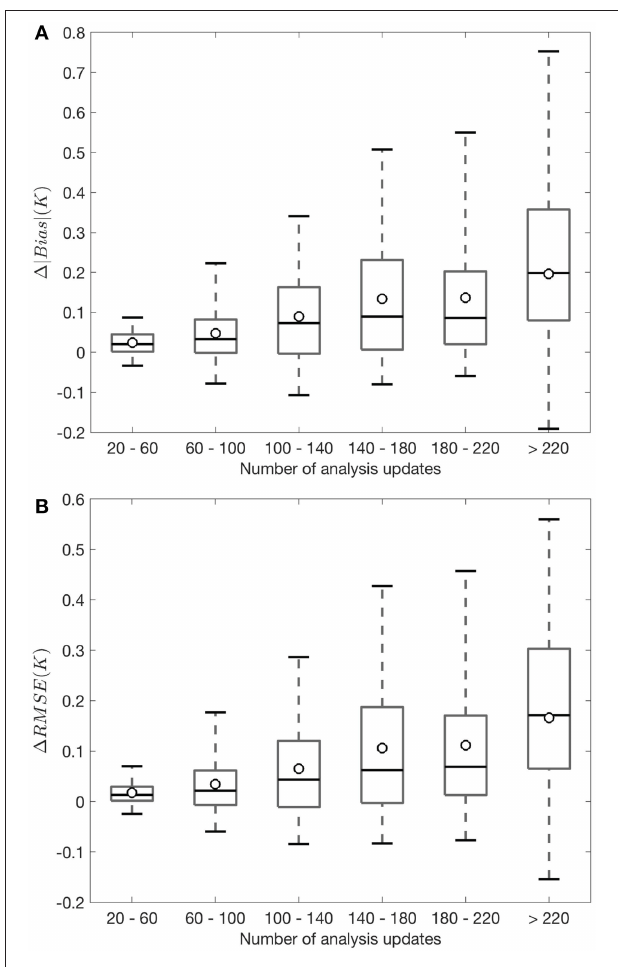
FIGURE 7 | Box plots of (A) 1 | bias | and (B) 1 RMSE computed between OL and FT DA during the comparison against MODIS derived surface temperature, which are binned as a function of the number of analysis updates per grid cell. The boxes show the median (marked as the black line in the box) along with the 25th and 75th percentiles while the whiskers show the 5 and 95th percentiles. The spatially-averaged skill metrics are marked as dots for each bin. The positive 1 RMSE and positive 1 | bias | indicate skill improvements in the FT DA relative to OL.